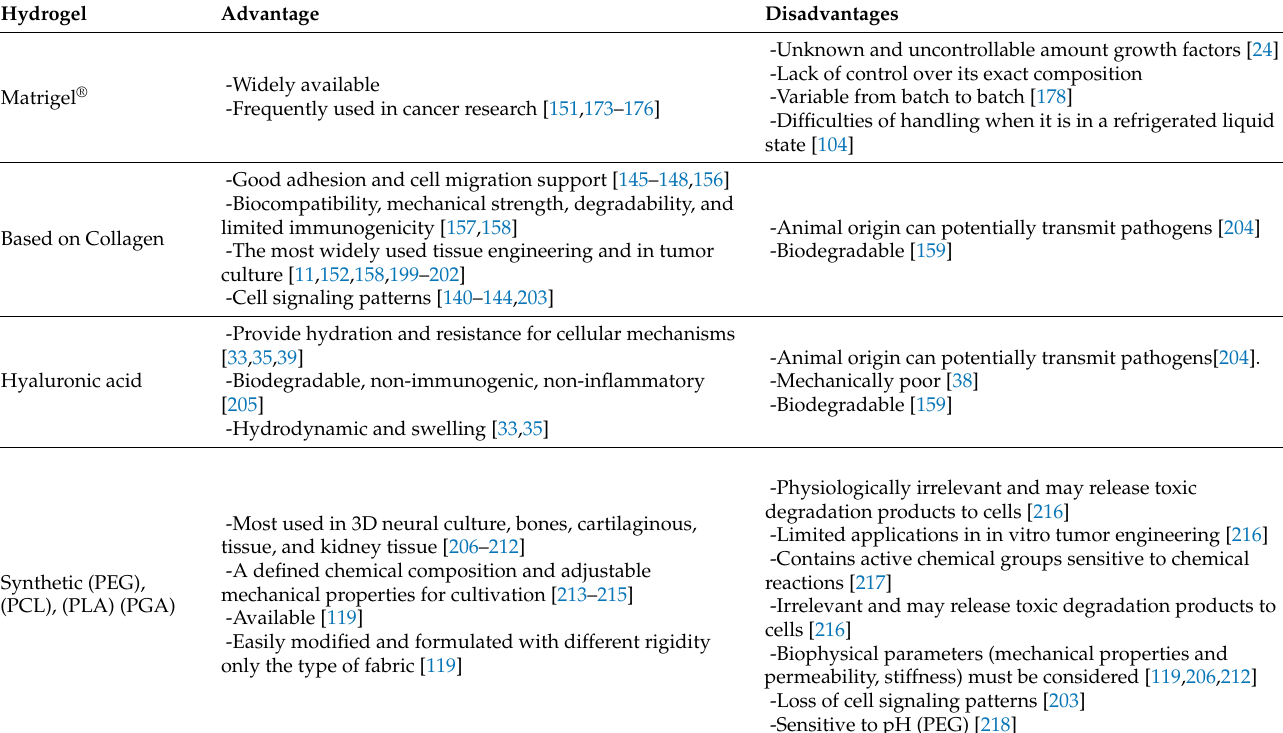
Table 3. Advantages and disadvantages of